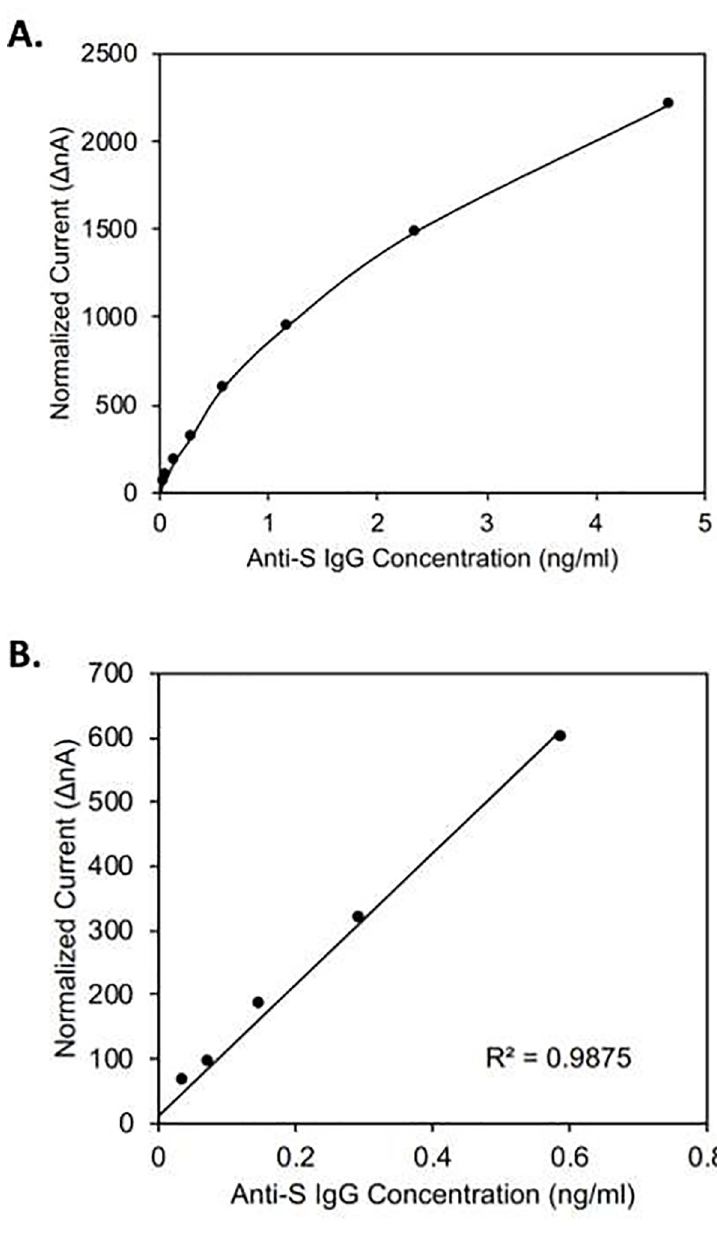
Fig 2. Dynamic range and linear range of Amperial ™ anti-Spike S1 IgG assay. X-axis: Amount of spike in anti- SARS-CoV-2 IgG in ng / ml. Y-axis: Normalized current in nA. Panel A: 0–5 ng / ml Panel B: 0.1–0.7 ng / ml.